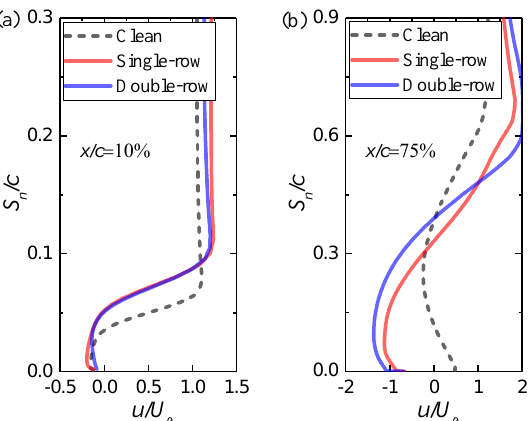
Figure 9. Streamwise velocity profiles at α = 27.67° ( ↑ ). S n denotes the normal distance away from the wall surface, and u the streamwise velocity. ( a ) x / c = 10%; ( b ) x / c = 75%.